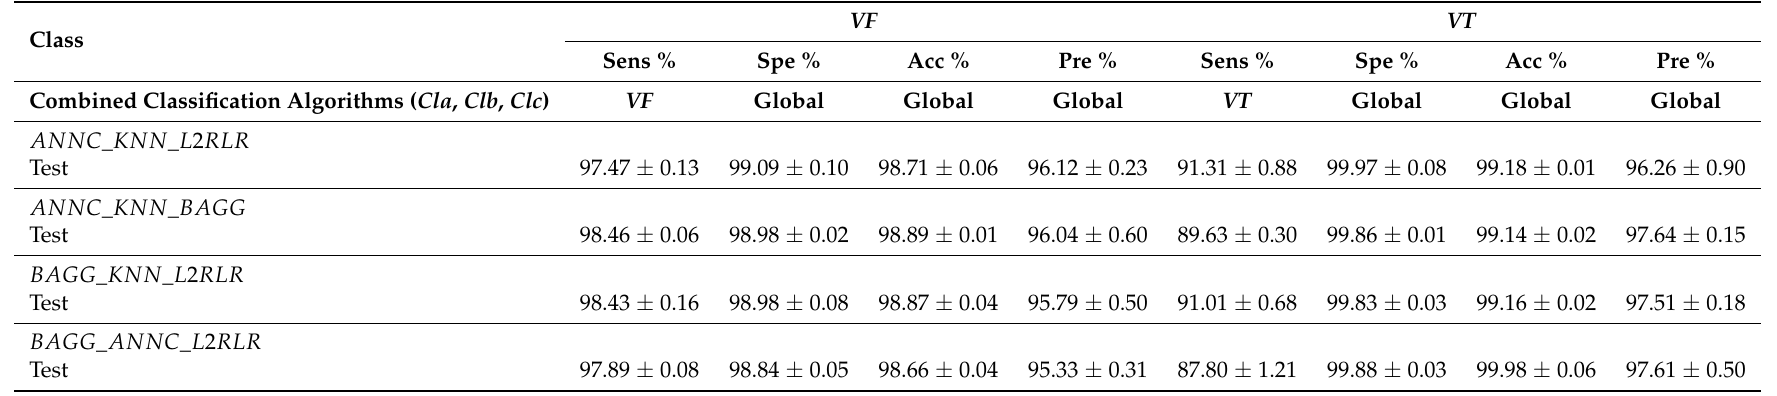
Table 5. Results for the voting majority method (VMM) combination method using TFRI as data input. Results correspond to detection of VF and VT pathologies.